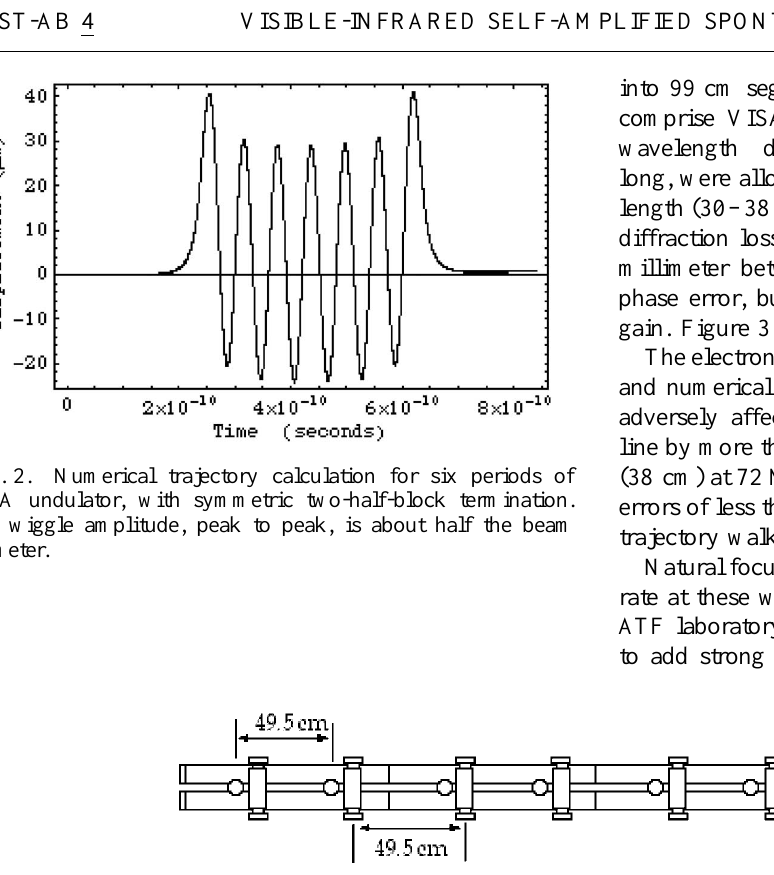
FIG. 3. Schematic side view of the VISA undulator, with end terminating magnets on both ends, pop-in diagnostic ports (circles), and steering trim coils (vertical oblong shapes).